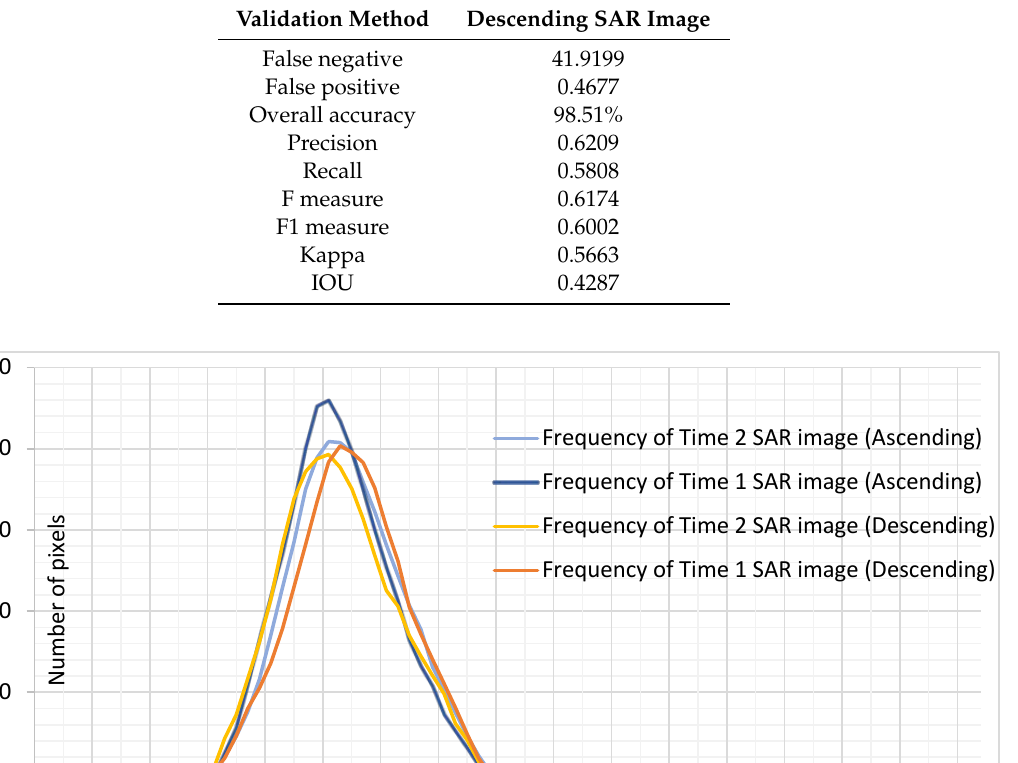
Figure 15. The result of the proposed method with descending SAR image data. The resolution of each image is 3.5 km × 3.5 km. ( a ) SAR image from 18 September 2008; ( b ) SAR image from 9 August 2010; ( c ) the proposed result; ( d ) comparison of the proposed result and the ground truth: (red) true positive area, (green) false positive area, (blue) false negative area. The accuracy shown is in Table 8. Table 8. Accuracy of the model with descending SAR data.